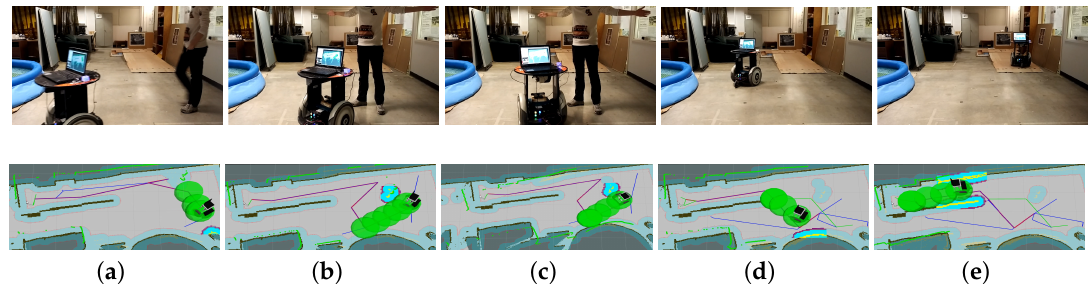
Figure 15. Dynamic obstacle avoidance (Task 5 in Table 3). ( a ) obstacle avoidance in the real scene; ( b ) the human suddenly blocks the way in front of the robot; ( c ) the robot changes direction to avoid the human; ( d ) the robot succesffully avoids the human; ( e ) the robot is climbing the